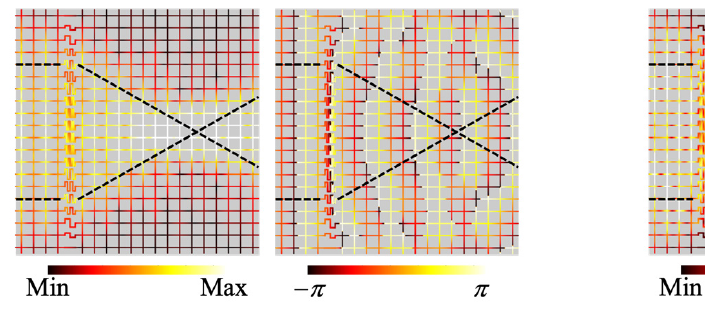
Amplitude Phase Amplitude Phase ( e ) ( f ) Figure 11. Complex sound pressure distributions for the acoustic flat lens: ( a ) 3.063 kHz ( λ = 8 ∆ d = 80 mm); ( b ) 3.500 kHz ( λ = 7 ∆ d = 70 mm); ( c ) 4.084 kHz ( λ = 6 ∆ d = 60 mm); ( d ) 4.900 kHz ( λ = 5 ∆ d = 50 mm); ( e ) 6.125 kHz ( λ = 4 ∆ d = 40 mm); ( f ) 8.167 kHz ( λ = 3 ∆ d = 30 mm). The left and right figures present the amplitude and phase, respectively. Incident plane waves illuminate the lens perpendicularly from the left-hand side of the analysis area and a focus is formed by these. The broken lines represent the theoretical propagation direction of incident and refracted waves, and the intersection is the theoretical position of the focus.